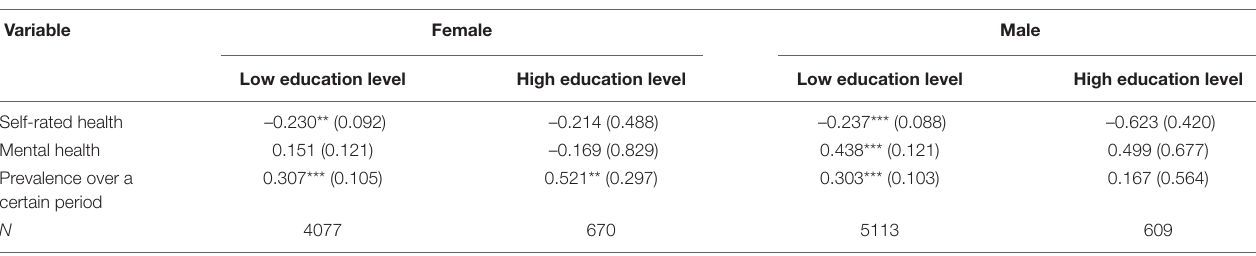
TABLE 6 | Robustness